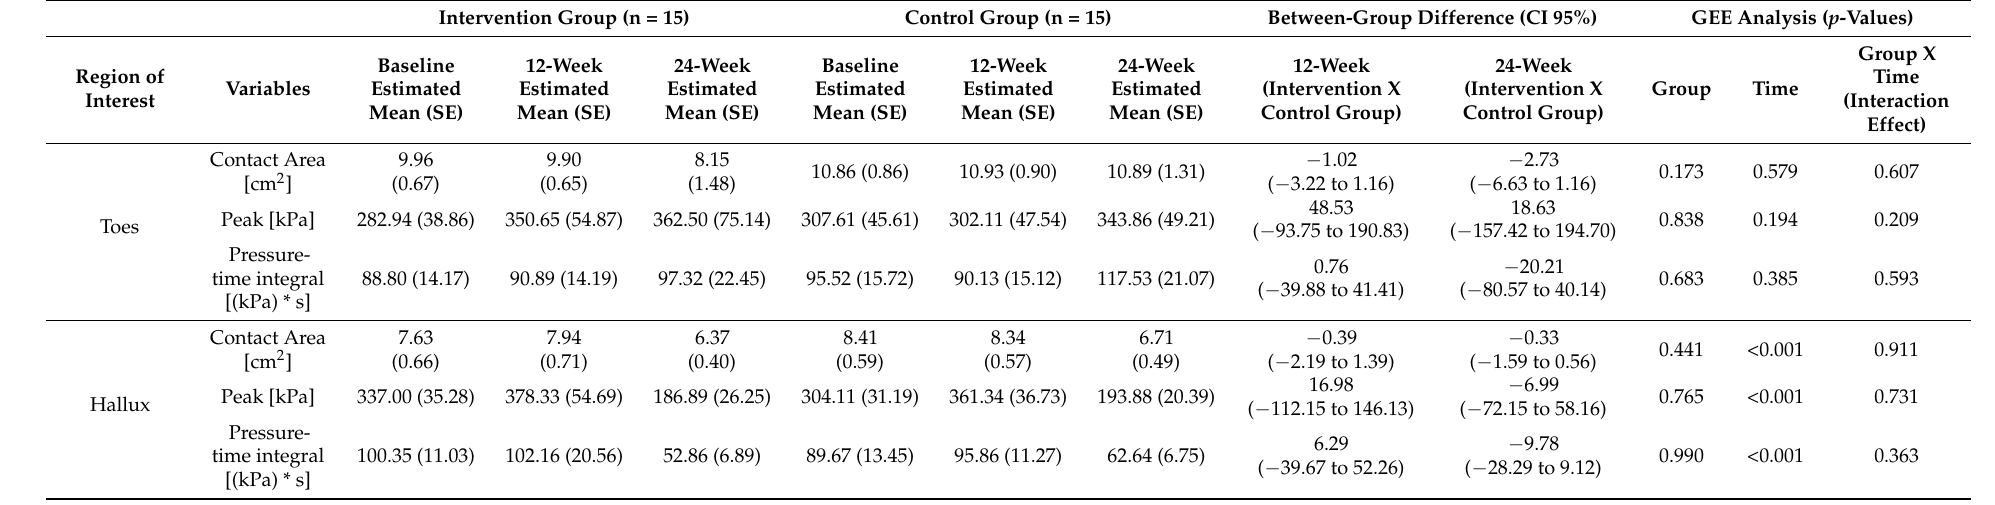
Table 3. Estimated mean (standard error; SE), p-values from Generalized Estimating Equation (GEE), and between-group mean differences at 12 and 24 weeks (95% confidence interval) of the plantar pressure variables during gait for the control and intervention